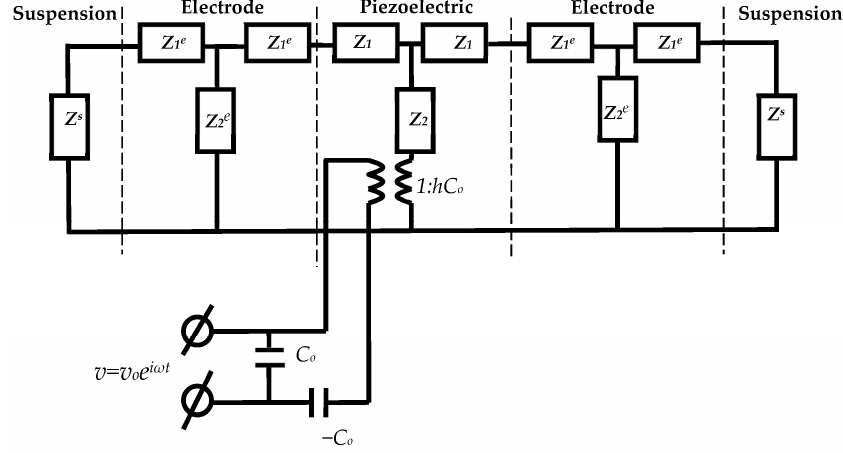
Figure 7. Equivalent circuit of the resonator with the electrodes loaded on both sides.